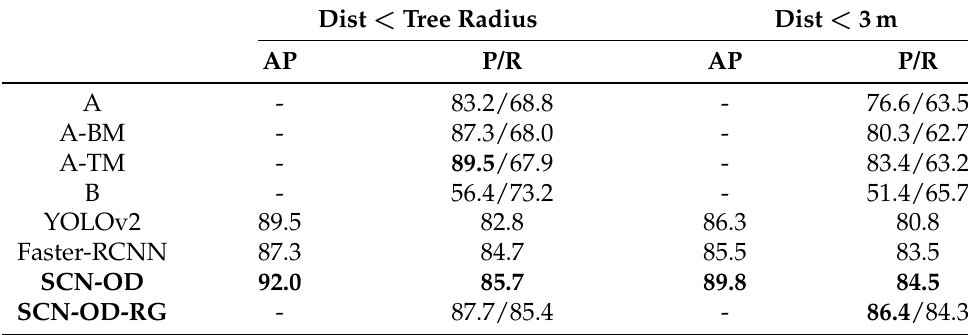
Table 3. Stem precision and recall in